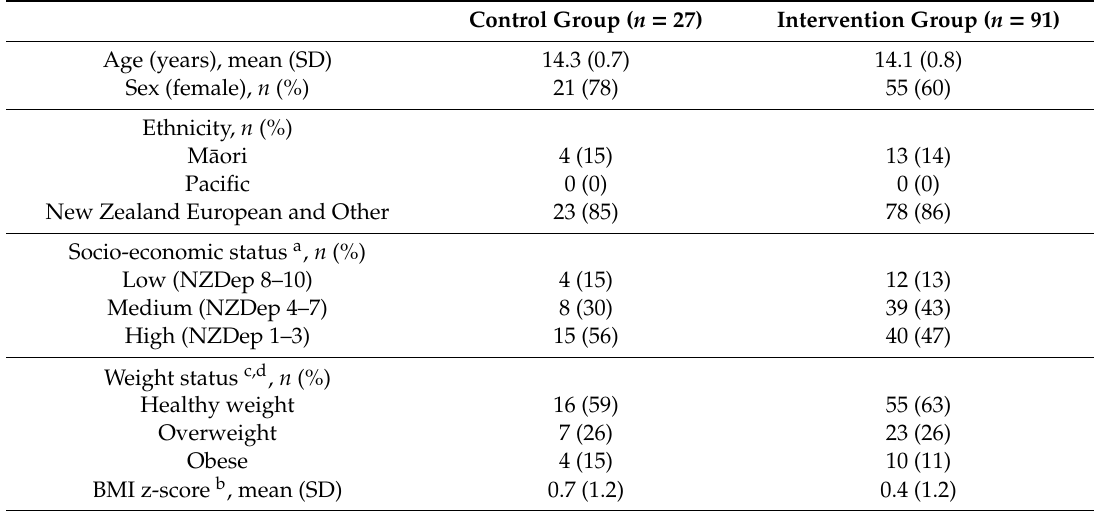
Table 1. Baseline characteristics of the COOK (Create Our Own Kai) Study participants ( n =